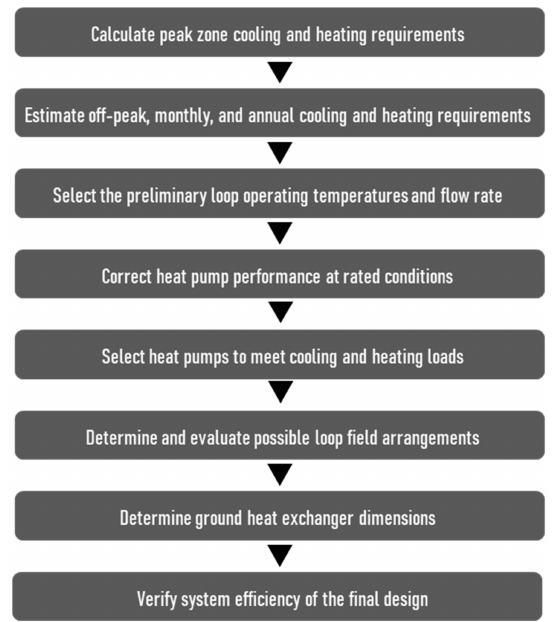
Figure 1. Existing design method for a ground source heat pump (GSHP) system